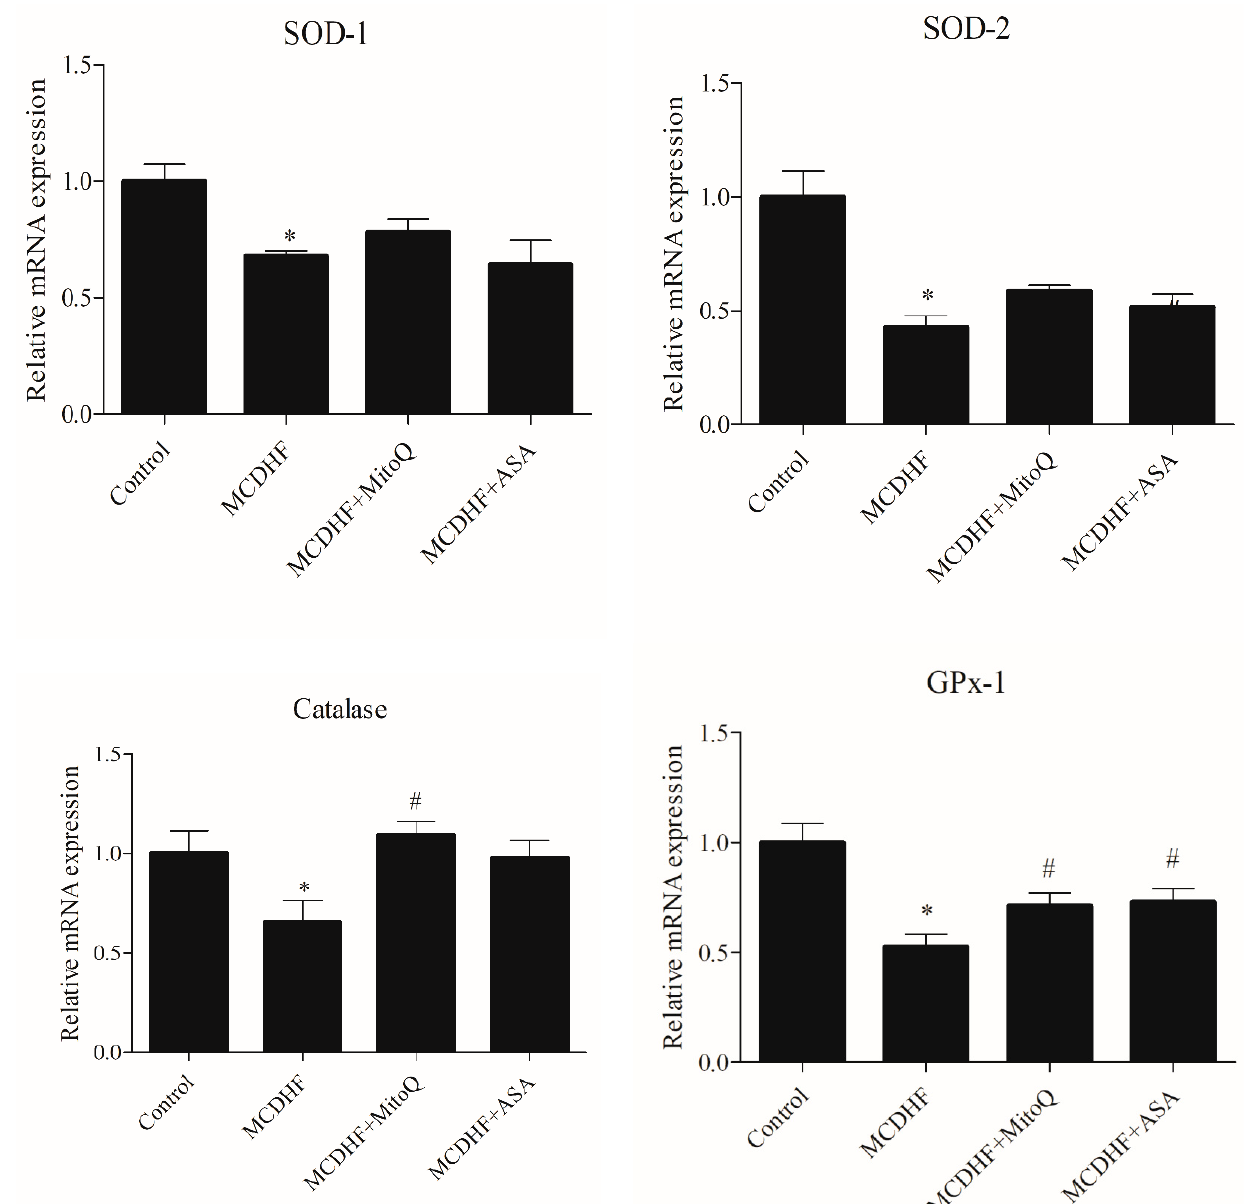
Figure 3. mRNA expression of SOD-1, SOD-2, catalase, and GPx-1 in livers from control, MCDHF, MCDHF + MitoQ, and MCDHF + ASA mice. * p < 0.05 vs. control; # p < 0.05 vs. MCDHF. In MCDHFD animals, the expression of antioxidant enzymes SOD-1, SOD-2, catalase, and GPx-1 was significantly reduced compared to controls; in MCDHFD mice, MitoQ significantly increased the expression of catalase and GPx-1, while ASA significantly increased the expression of GPx-1. Gene expression of Col1a1, TGF β -1, TIMP-1, MMP-2, and MMP-9, which are associ- ated with liver fibrosis, was significantly higher in MCDHFD mice than in control animals. In MCDHFD animals, MitoQ decreased the expression of TGF β -1, TIMP-1, MMP-2, and MMP-9, while ASA decreased the expression of TGF β -1, TIMP-1, and MMP-2 (Figure 4).